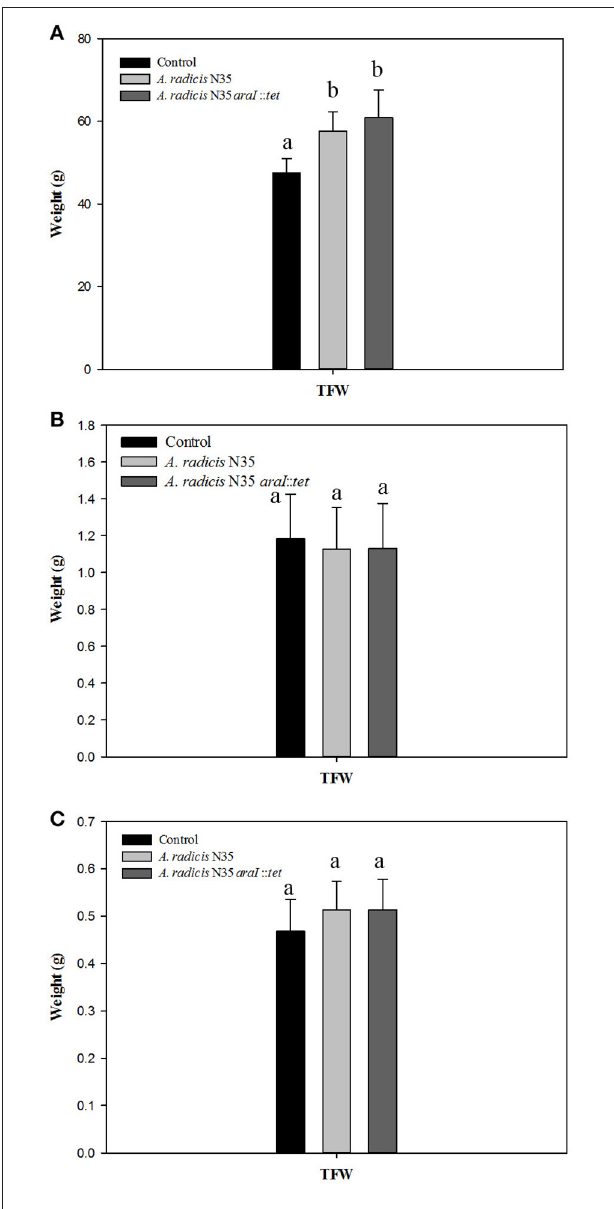
FIGURE 3 | (A,B) Total fresh weights (TFW) of barley seedlings grown in soil after inoculation with A. radicis N35 wild type or the araI mutant after 2 months and 2 weeks, respectively. (C) Total fresh weight of barley seedlings 2 weeks after inoculation with A. radicis N35 wild type or the araI mutant, respectively, under axenic growth condition. Different letters indicate significant differences among treatment groups ( p < 0.05).